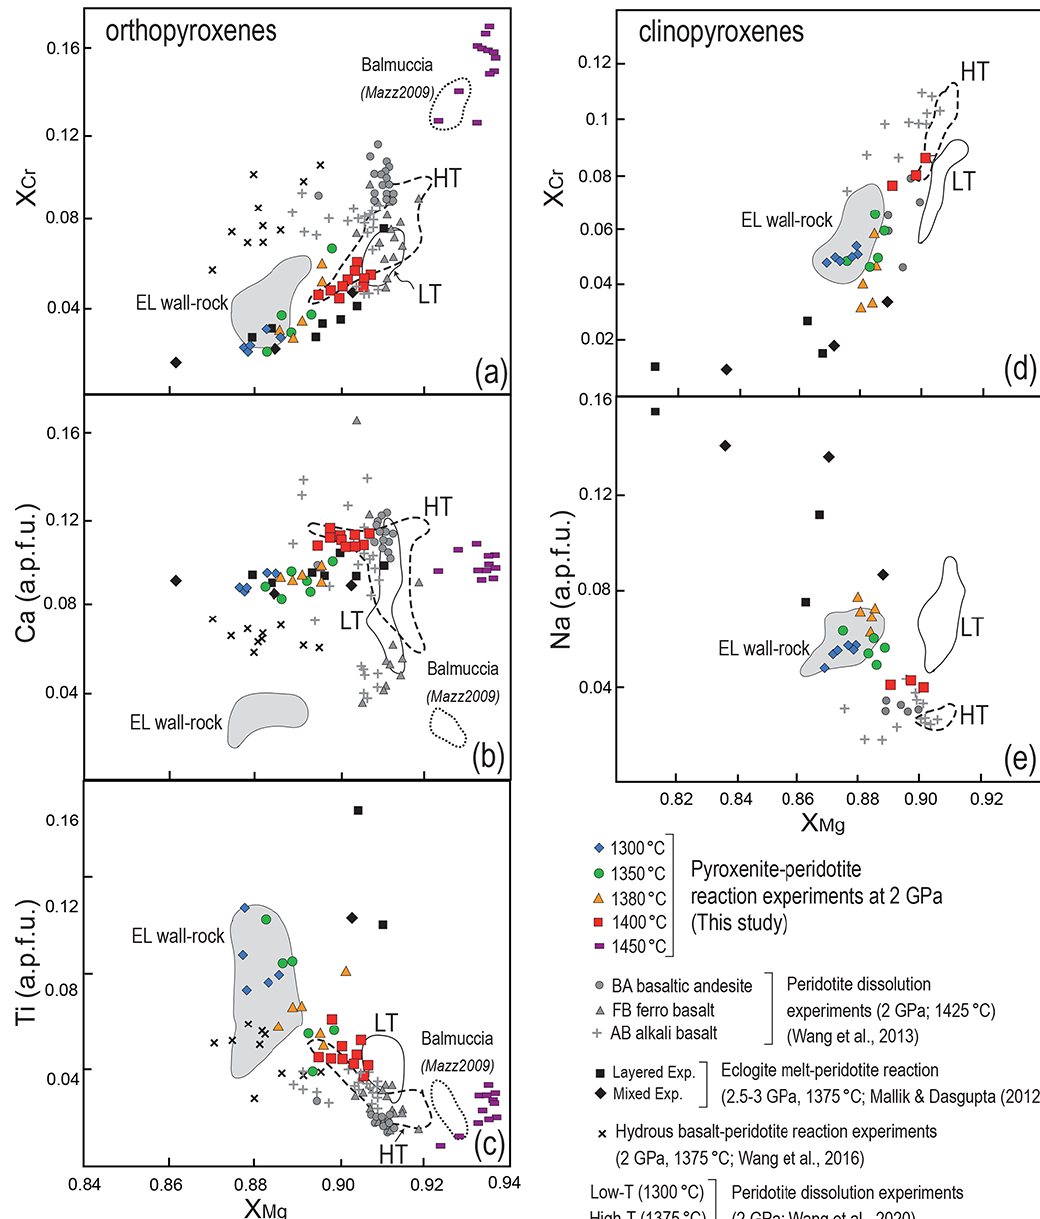
Figure 11. Compositional variations in orthopyroxene (a–c) and clinopyroxene (d–e) from reaction zones produced in pyroxenite–peridotite experiments from this study compared with those from previous experimental studies at comparable P – T conditions: (i) peridotite dissolution experiments at 2GPa and 1425 ◦ C using basaltic andesite (BA), ferro-basalt (FB) and alkali basalt (AB) by Wang et al. (2013), (ii) melt– peridotite reaction experiments using a hydrous basaltic melt at 2GPa and 1375 ◦ C (Wang et al., 2016), (iii) reaction experiments between MORB-eclogite-derived (mid-ocean ridge basalt) melt and peridotite at 2.5–3GPa and 1375 ◦ C (Mallik and Dasgupta, 2012), as well as experiments of peridotite dissolution in eclogite-derived melt at 1300 ◦ C (LT) and 1375 ◦ C (HT) by Wang et al. (2020). Also reported are the fields defined by mineral compositions of metasomatised wall-rock peridotites from External Liguride mantle sequences (northern Apennines, Italy; Borghini et al., 2020) and dunites from Balmuccia peridotite massif (western Italian Alps, Italy; Mazzucchelli et al., 2009).